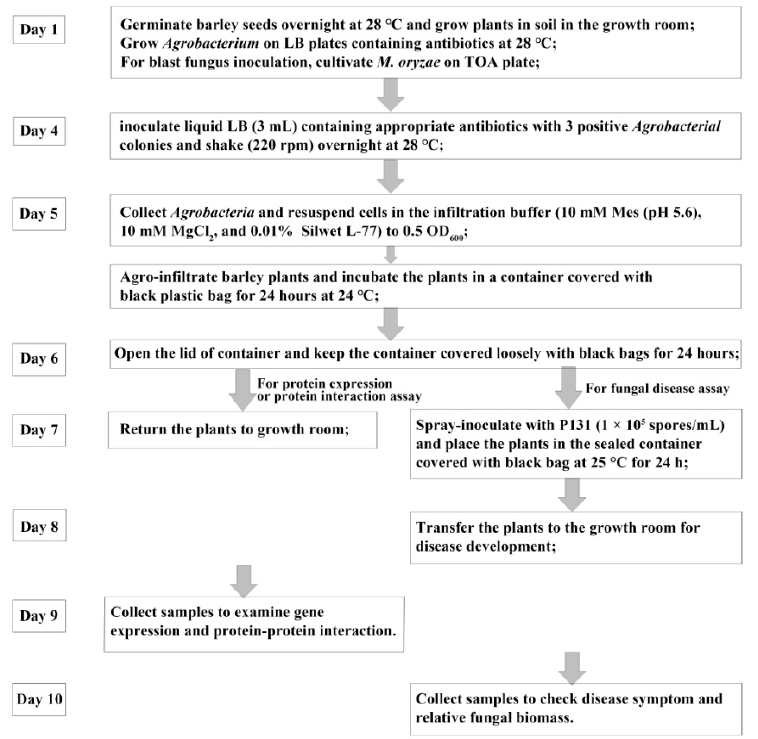
Figure 3. The flow chart of the AMTE. The details of experimental conditions can be found in Figure 3. The fl ow chart of the AMTE. The details of experimental conditions can be found in Mate- Materials and rials and Methods.